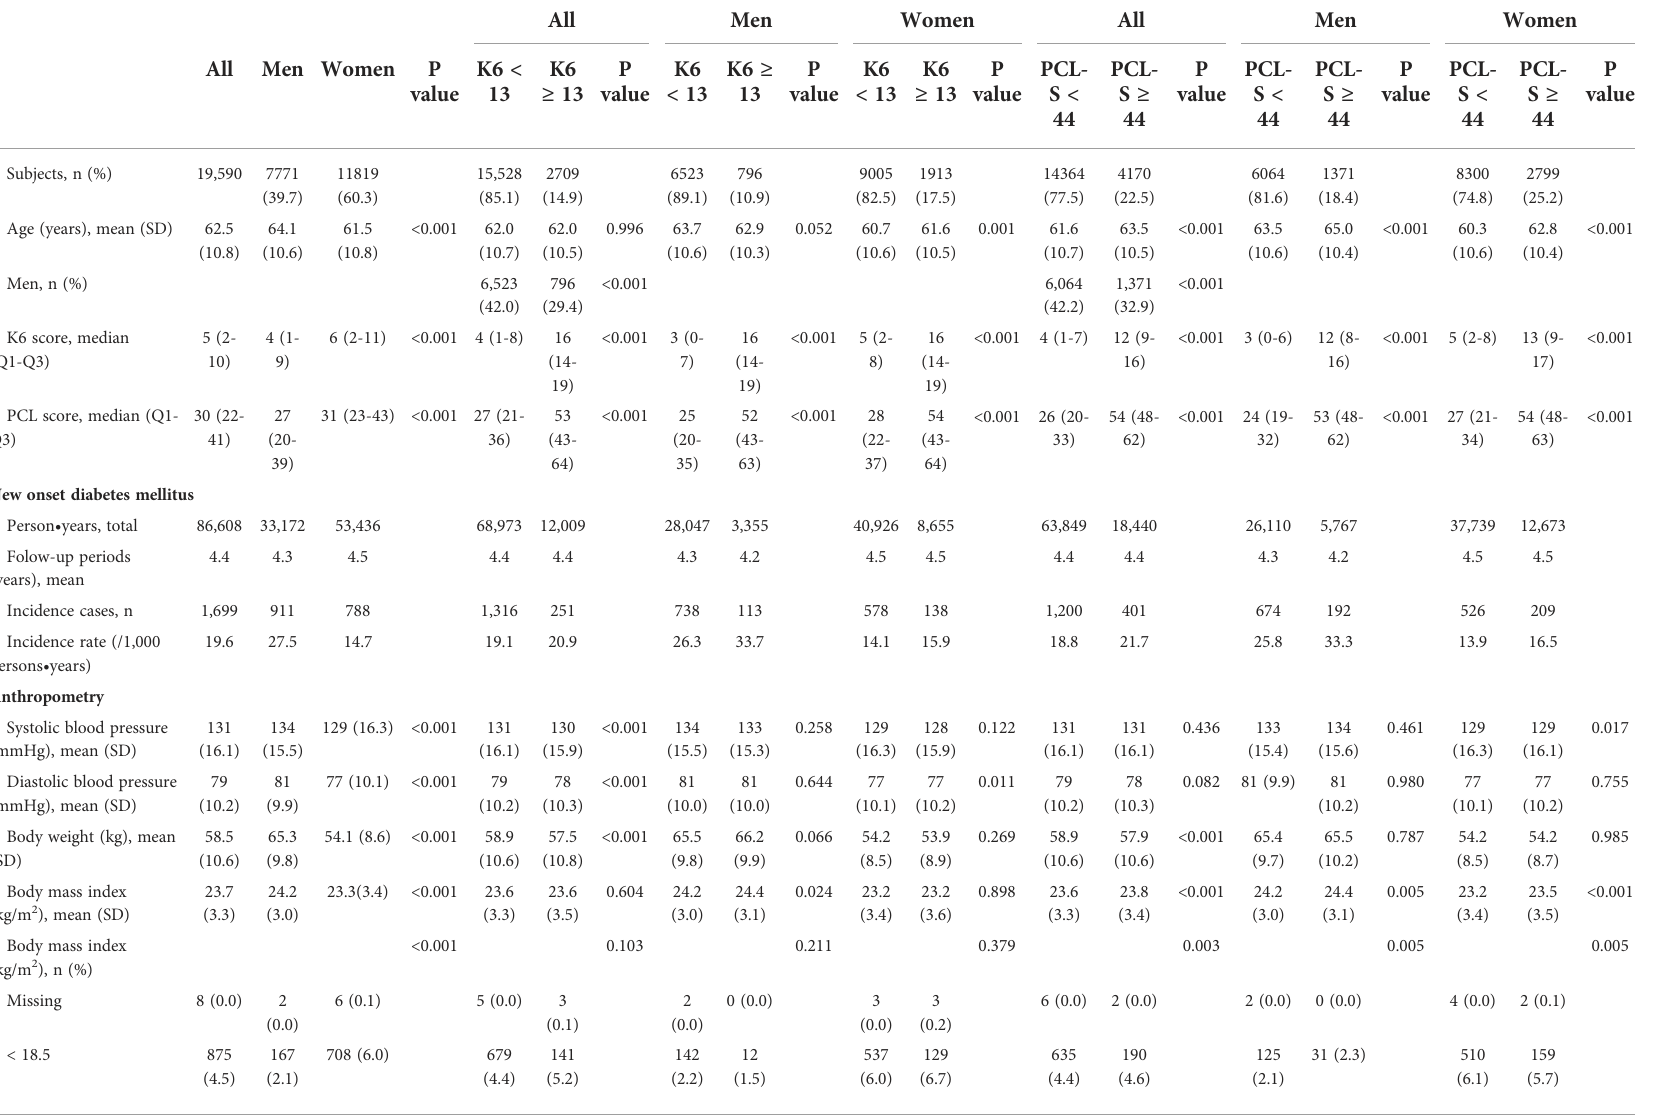
TABLE 1 General characteristics of participants at baseline. All Men Women All Men